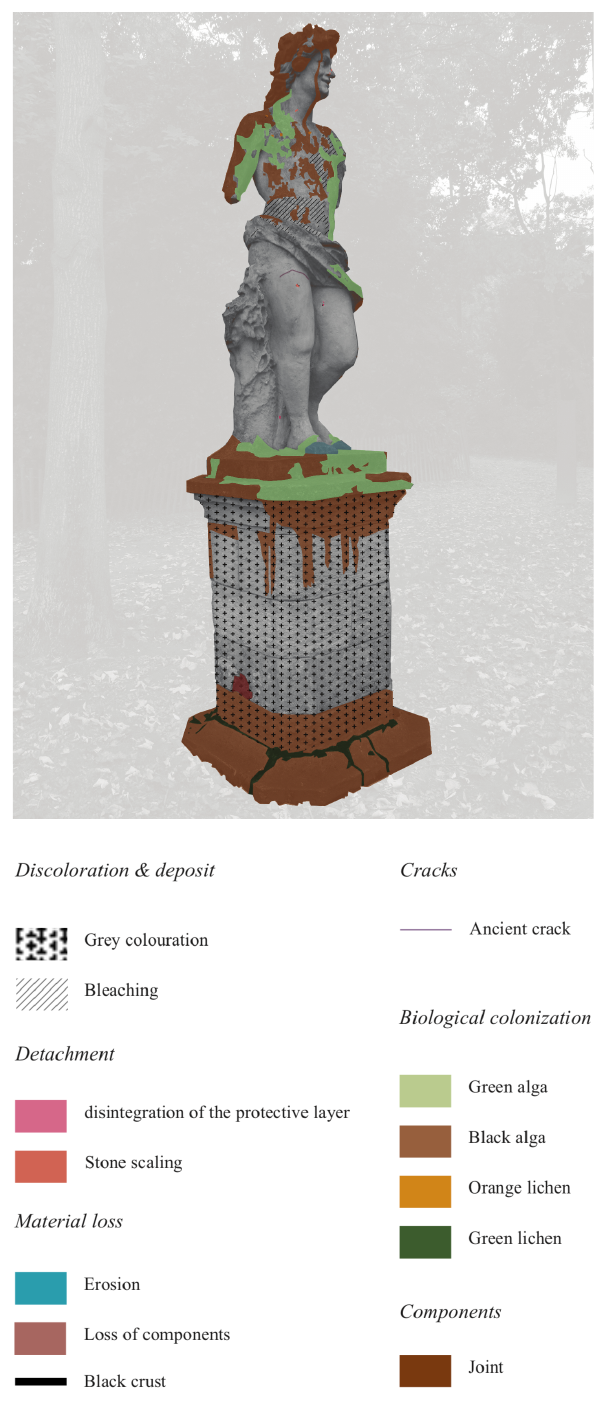
Figure 6. Alterations in 2018 and